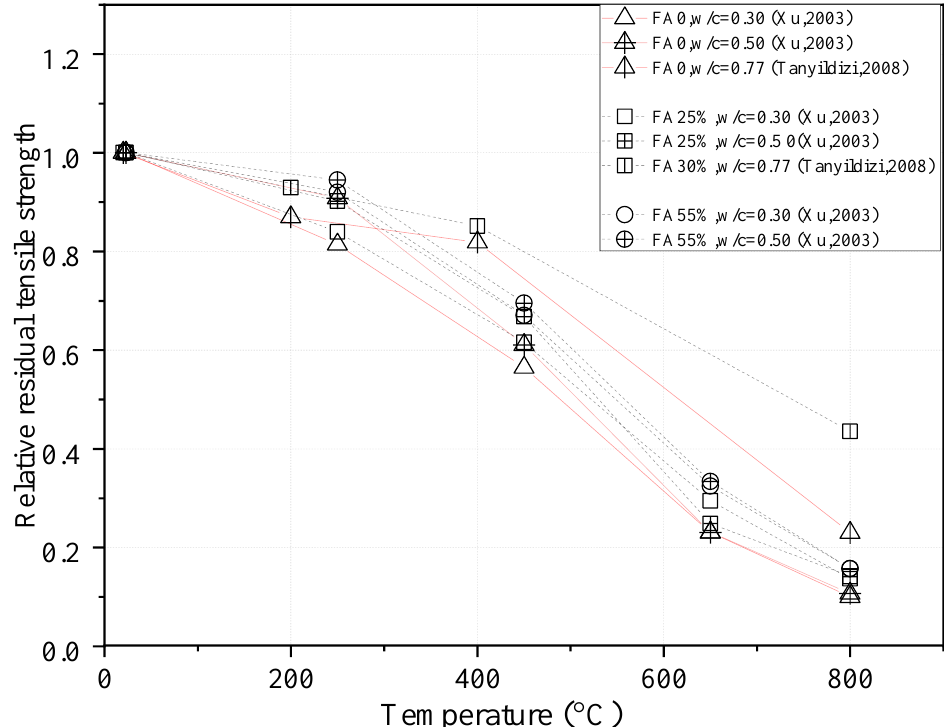
Figure 7. The relative residual tensile strength of concrete containing fly ash (FA) at different water- to-cementitious materials ratios (w/c) [41,43].